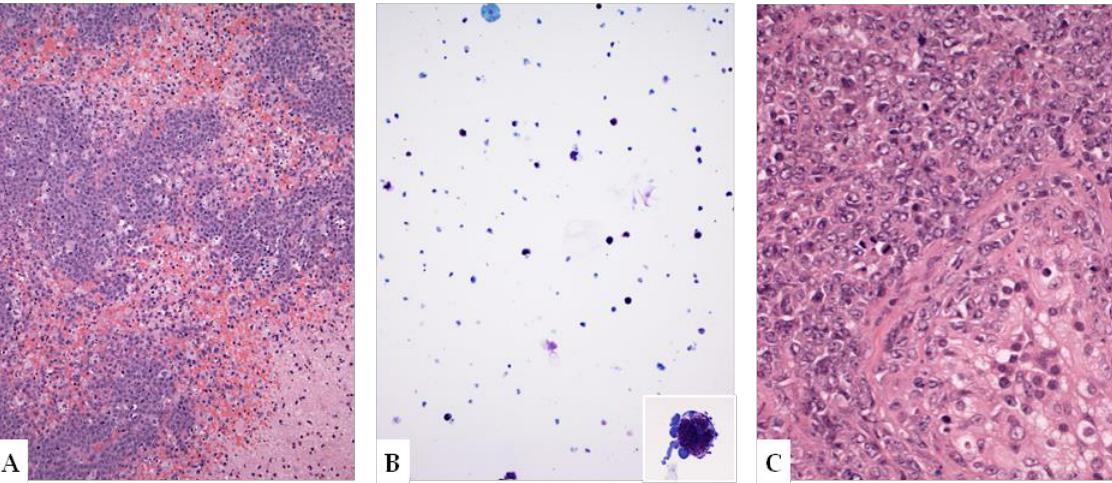
Figure 5. Large B-cell lymphomas (LBCL) of immune-privileged sites (WHO-HAEM5) include primary CNS lymphomas ( A ), primary vitreoretinal lymphoma ( B ), and primary testicular lymphoma ( C ). The vitroretinal lymphomas are often associated with a significant amount of debris within the vitreous fluid with only scattered neoplastic cells (( A ). hematoxylin and eosin stain 10× original magnification; ( B ). Giemsa stain 20× original magnification, inset 100× original magnification; ( C ). hematoxylin and eosin 10× original magnification).